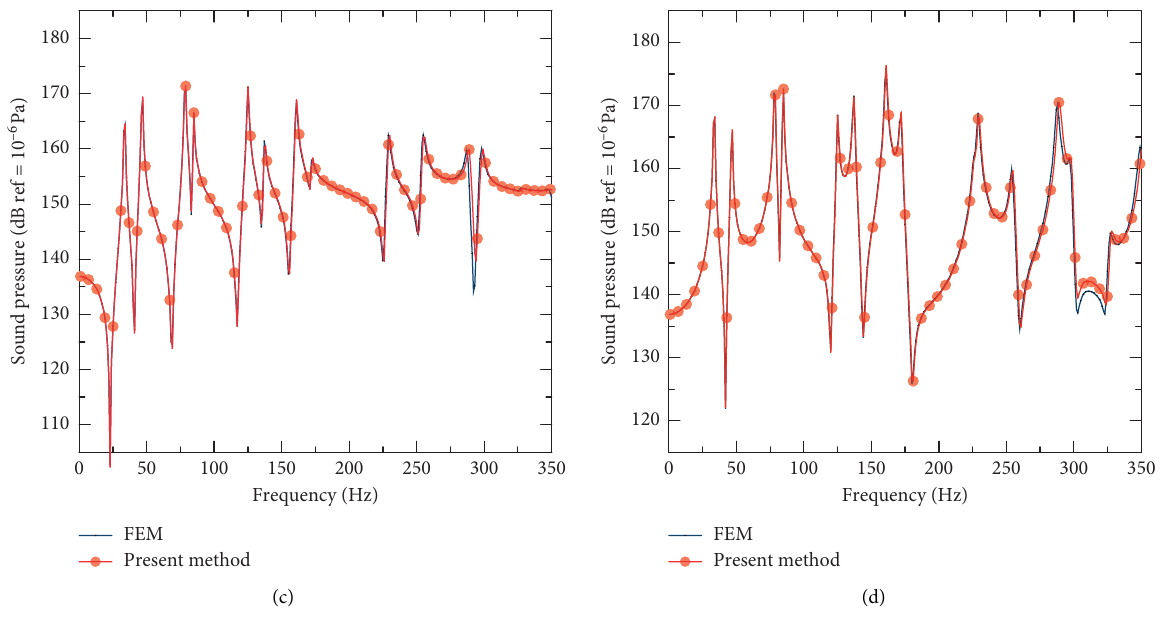
Figure 5: Response under point force source excitation. (a) Velocity response at (0.10, 0.12, 0.14). (b) Velocity response at (0.15, 0.30, 0.14). (c) Sound pressure response at (0.08, 0.11, 0.07). (d) Sound pressure response at (0.20, 0.33,